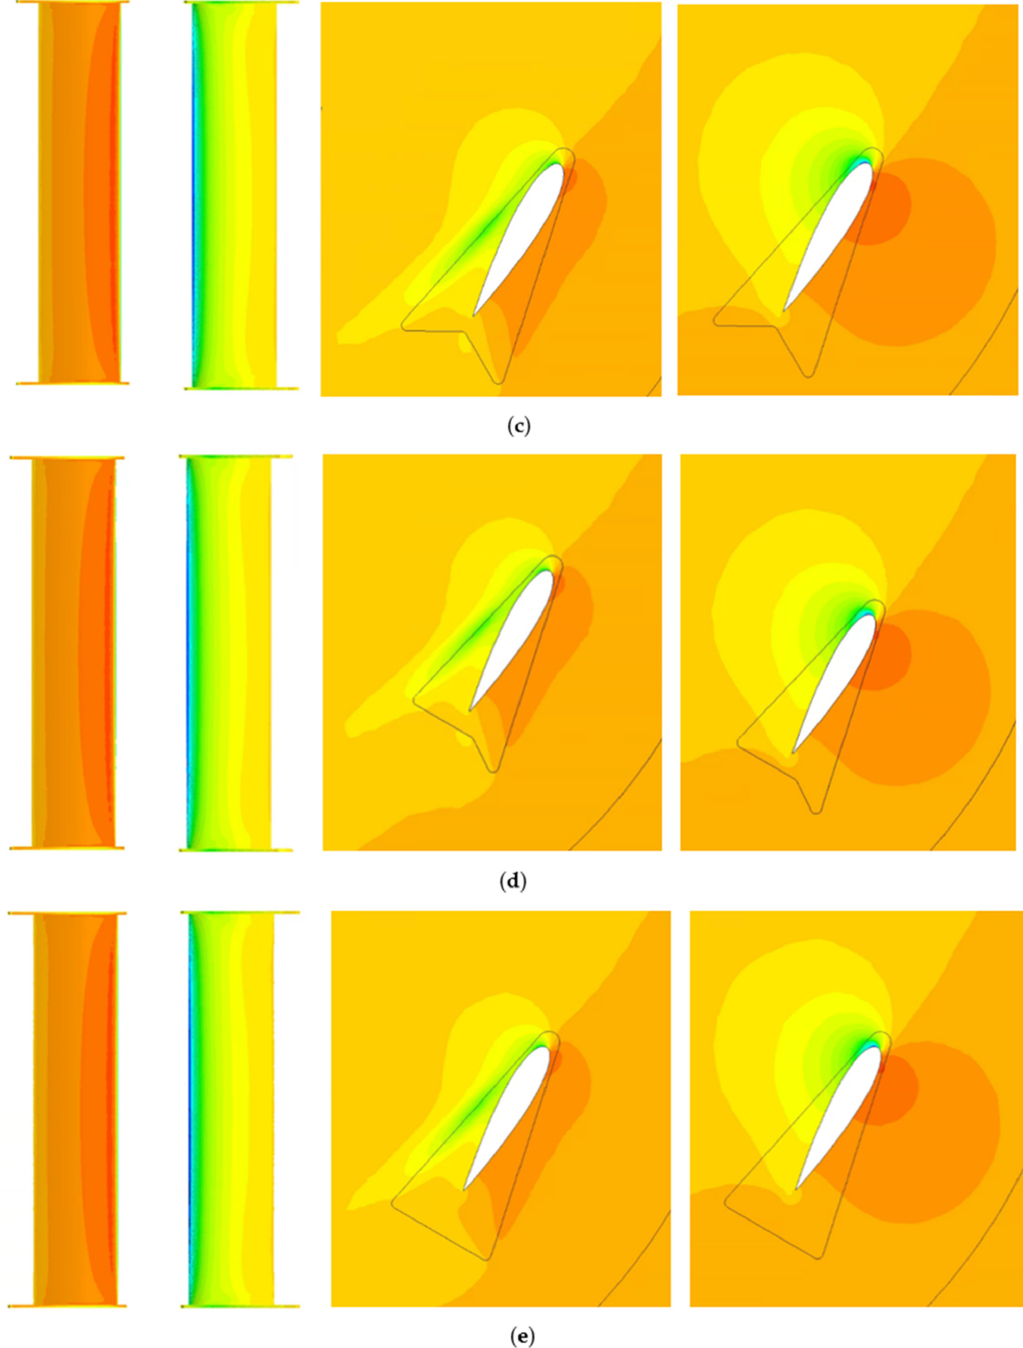
Figure 14. From left to right is the pressure distribution at the pressure side, suction side, at 0.015625H and 0.5H of Blade 1 at θ = 60° and TSR 1 for ( a ) baseline, ( b ) offset, ( c ) symmetric V, ( d ) asymmetric and ( e ) triangular endplates.